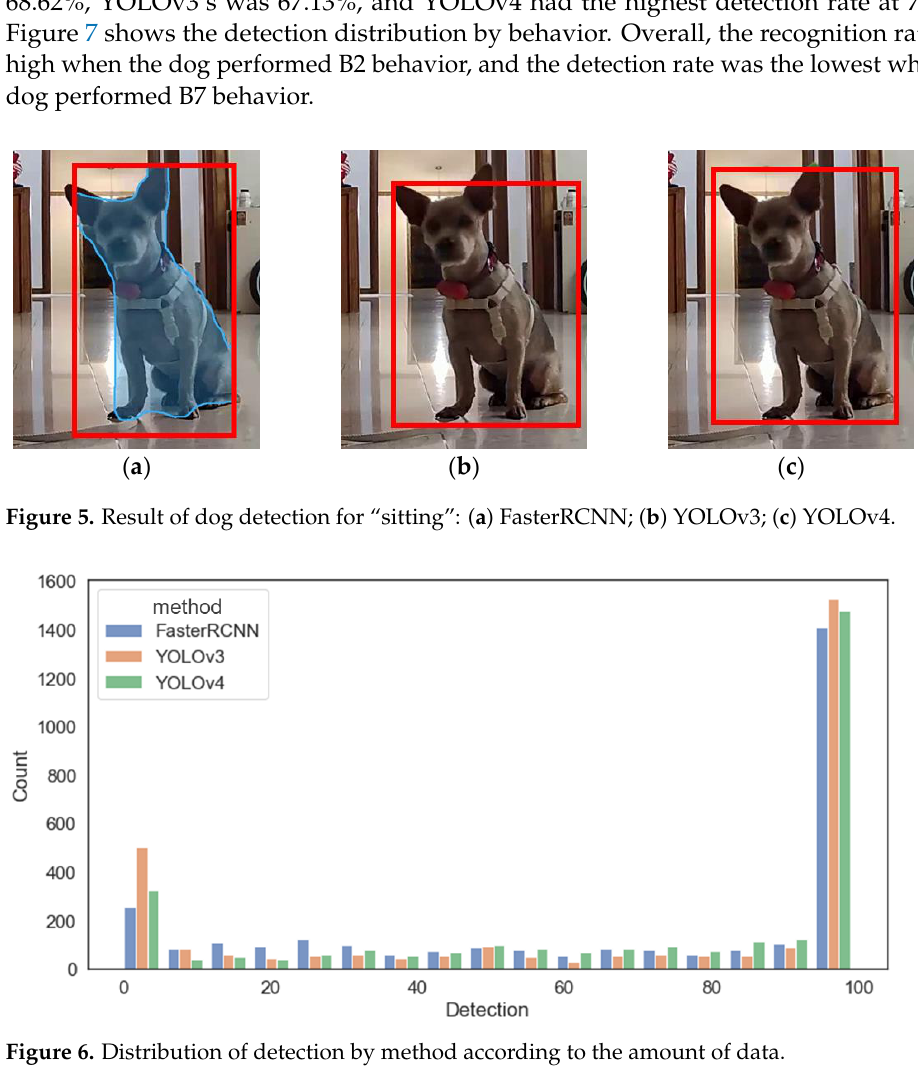
( c ) Figure 7. Distribution of detection by dog behavior per method: ( a ) FasterRCNN; ( b ) YOLOv3; ( c ) YOLOv4. Table 5 shows the performance evaluation results for behavior recognition with the object detection method using only video data. On average, the accuracy was 86.7%, and among the methods, YOLOv4 had the highest accuracy (89.2%). Figure 8 shows the fusion matrix of behavior recognition by behavior. In general, B1 – B4, which did not involve movement, had a high recognition rate. In contrast, in the case of B7, since the B7 data of FasterRCNN were too small compared to that of YOLOv3 and YOLOv4, it was judged that YOLOv3 and YOLOv4 were relatively well aware of running, whereas FasterRCNN was not. Table 5. Results of behavior recognition performance evaluation by dog detection methods using video data. Dog Detection Method